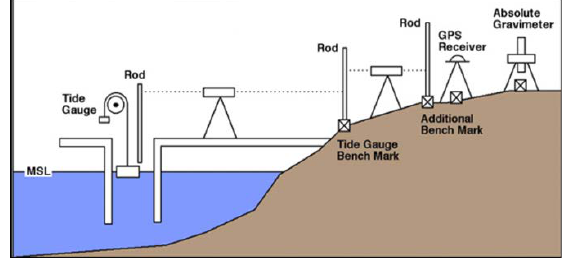
Figure 2. A schematic diagram of a tide gauge